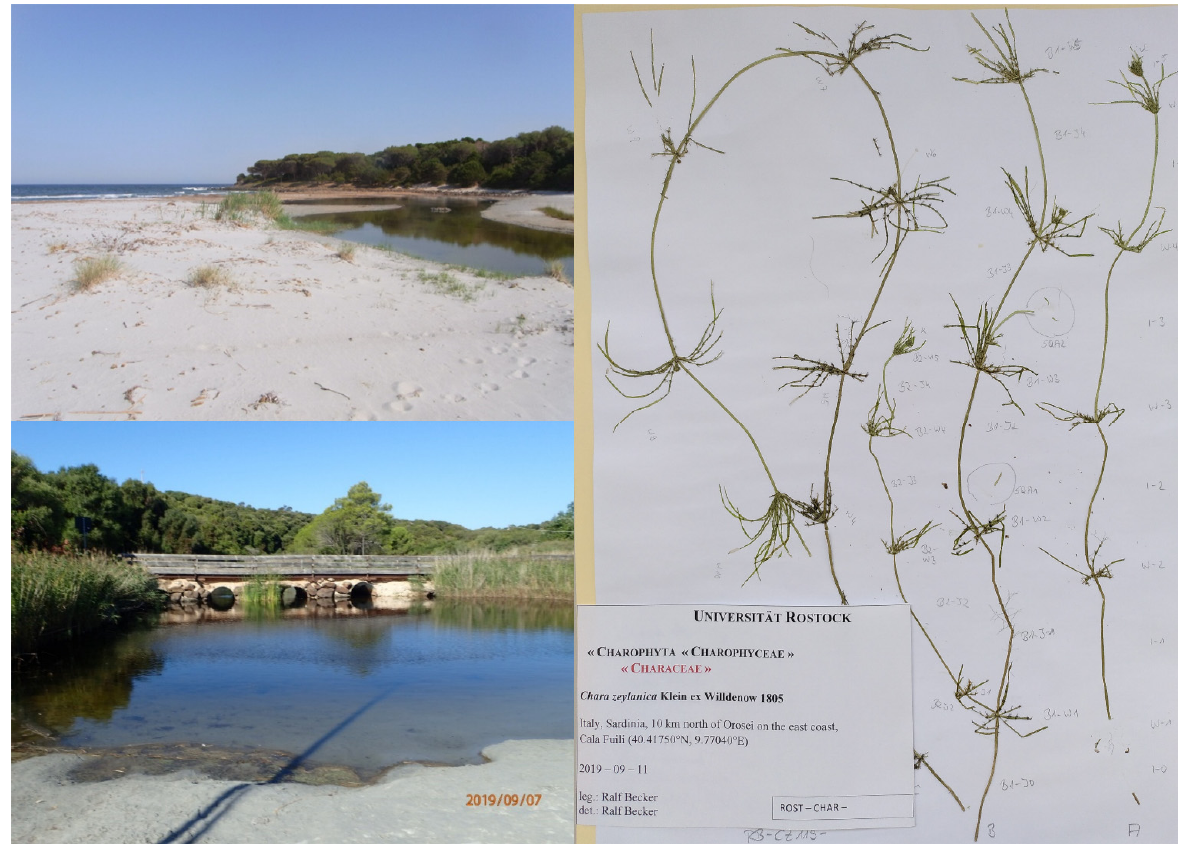
Figure 1. Habitat photographs ( left panels ) and habitus ( right panel ) of specimens collected at Cala Fuili, Sardinia. Plants were collected in the widening of the small stream just in front of the bridge.